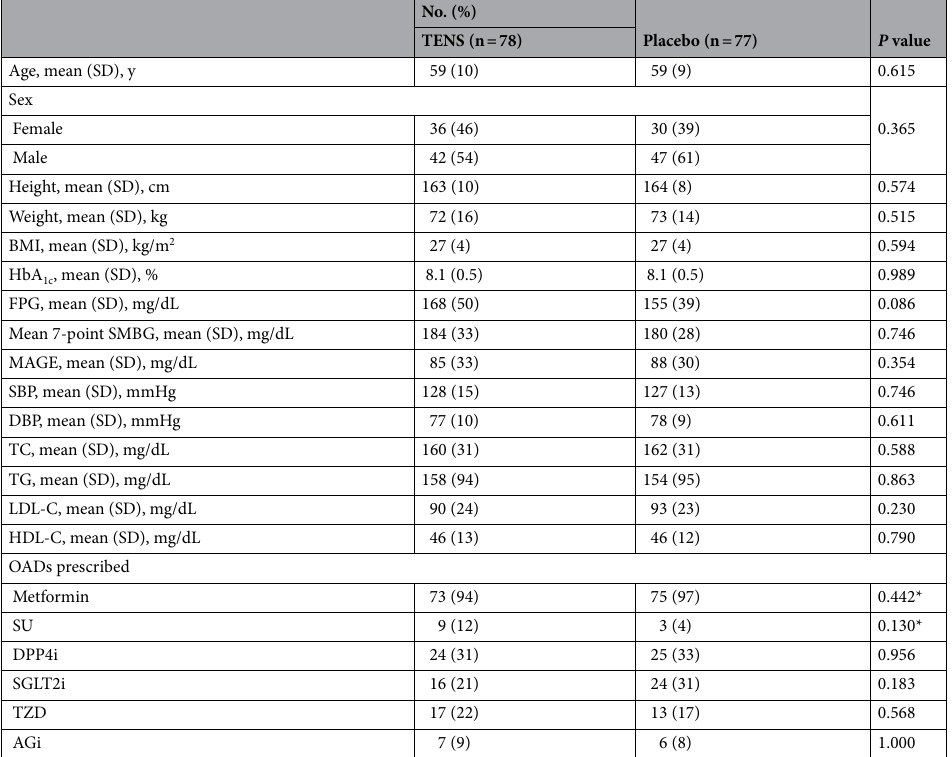
Table 1. Baseline Demographics, Clinical Characteristics and Prescribed Oral Antidiabetic Drugs. Data are presented in means ± SD unless otherwise indicated. Two-sample t -test was conducted for continuous variable; Chi-square test or Fisher’s exact test were conducted for categorical variable. TENS the study device “Dragon Waves Resonant Home Care” Electronic Nerve Stimulator, BMI body mass index, HbA 1c